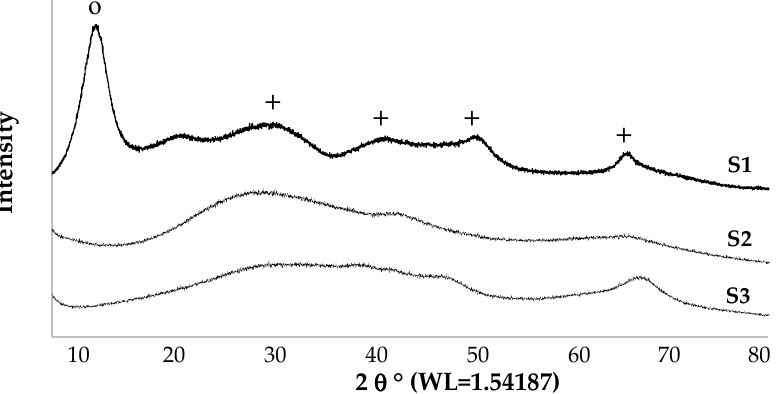
Figure 1. Diffractograms of samples S1–S3 (+, PB; o, aluminum complex).